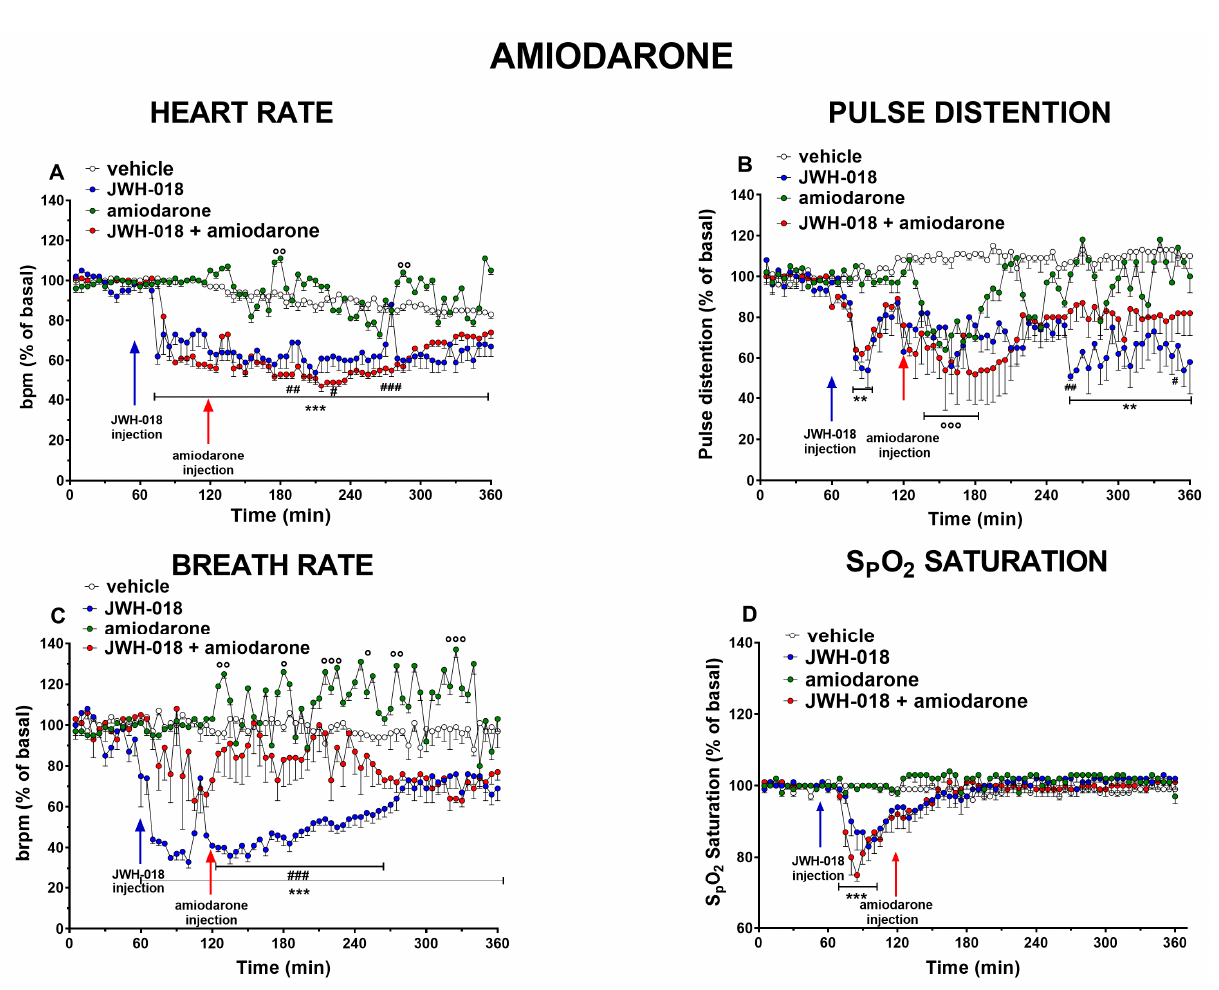
Figure 1. Effect of systemic administration of JWH-018 (6 mg/kg), amiodarone (5 mg/kg), and JWH-018 followed by amiodarone on heart rate ( A ), pulse distention ( B ), breath rate ( C ), and arterial oxygen saturation ( D ). Data are expressed as percentage of basal values in the form mean ± SEM of eight different evaluations for each group. Statistical analysis was performed by two-way ANOVA followed by Bonferroni’s test for multiple comparisons. ** p < 0.01, *** p < 0.001, JWH-018 versus vehicle. # p < 0.05, ## p < 0.01, ### p < 0.001, JWH-018 versus JWH-018 + amiodarone. ° p < 0.05, °° p < 0.01, °°° p < 0.001, amiodarone versus vehicle.